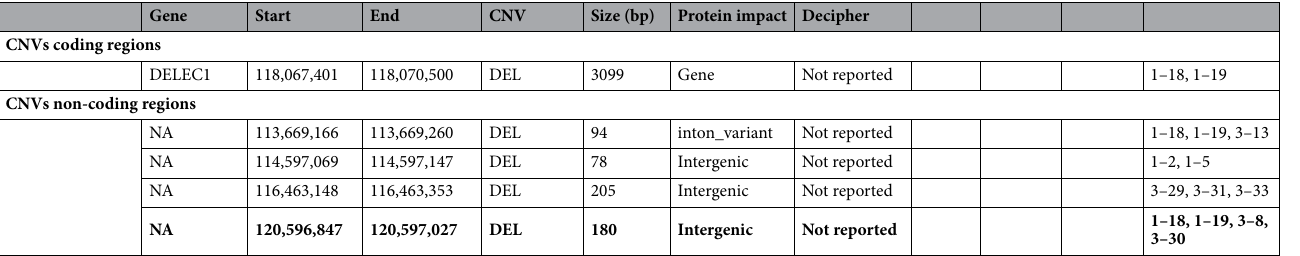
Table 2. Rare genomic SNVs, INDELs and CNVs identified in the Chromosome 9 (chr9: 12,400,417– 113,467,798) linked region. In bold are highlighted the genomic rare variants identified in the